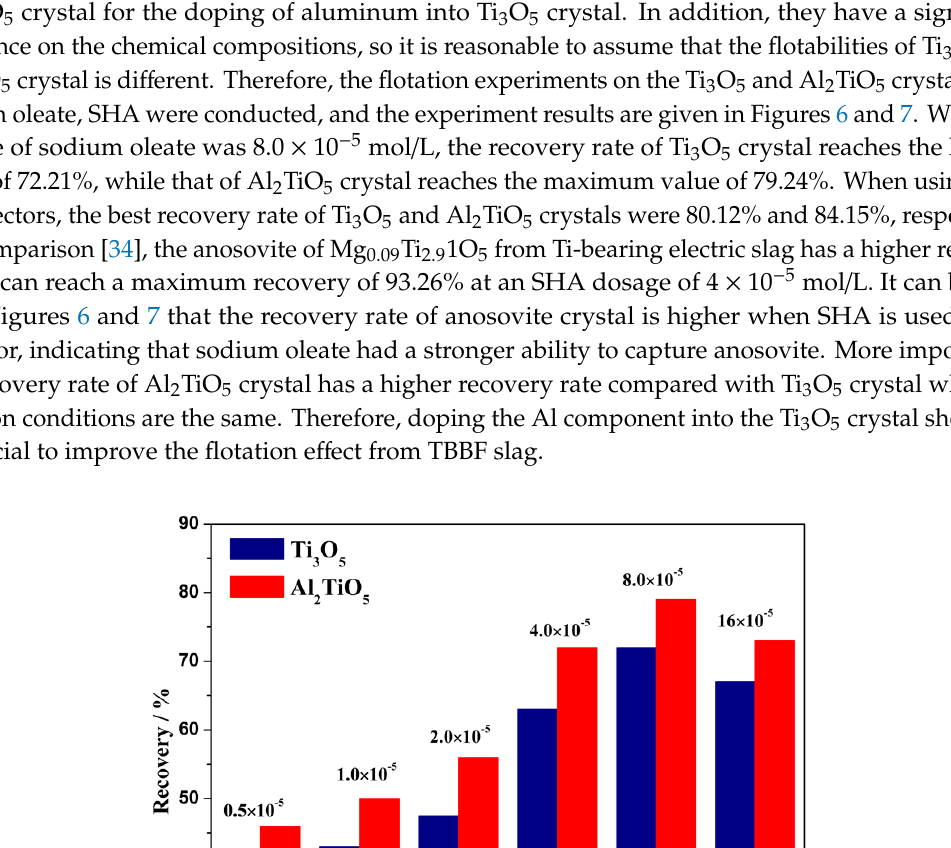
Figure 7. Dosage effect of SHA on the Flotability of Ti 3 O 5 and Al 2 TiO 5 crystals (pH = 7). 4. Conclusions In this paper, DFT is used to study the effects of Al on anosovite crystal structure, electronic structure, and flotation behavior. Moreover, the flotation experiment on Ti 3 O 5 and Al 2 TiO 5 crystals are conducted, and DFT calculation results are accurate. The main conclusions are as follows: (1) The energy of all Al 2 TiO 5 band increased about 2 eV compared with that of Ti 3 O 5 , indicating that the valence and conduction bands have increased in energy. The energy band shifts to the positive direction promotes the flotation effect. (2) Compared with Ti 3 O 5 crystal, O atom obtains more electrons in Al 2 TiO 5 crystal because the Ti atom receives electrons more easily than Al atoms in the Al 2 TiO 5 crystal. The Al 2 TiO 5 crystal possesses a larger Ti–O bond population than Ti 3 O 5 , and the Ti–O bonds length is shorter; therefore, the covalency of Al 2 TiO 5 crystal is stronger. Moreover, the Al–O bonds covalency in the Al 2 TiO 5 crystal is greater than that in the Ti 3 O 5 crystal.